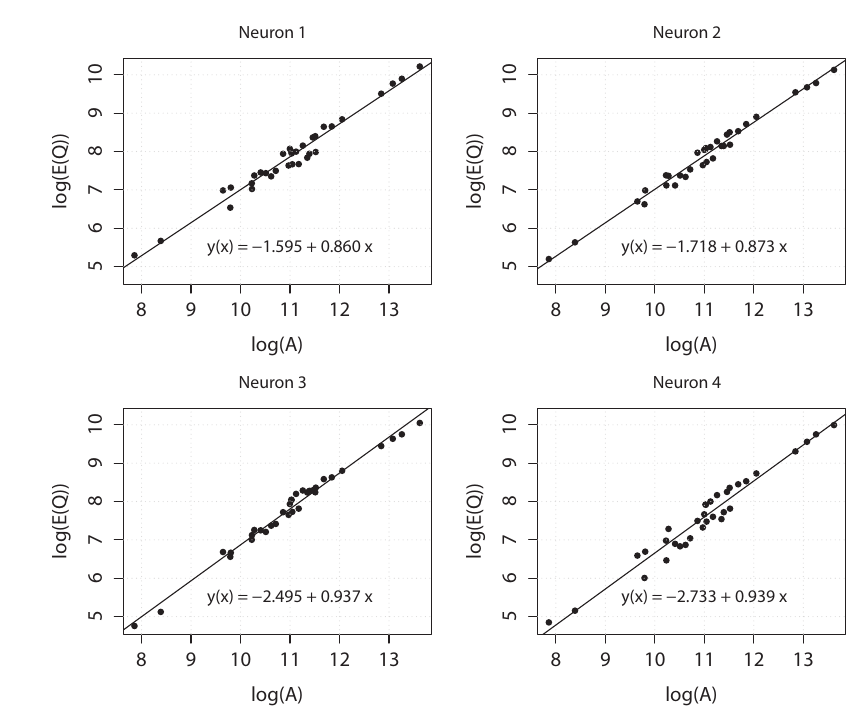
Figure 11. Scaling of average flood flow series in each neuron class. The least-square estimates of intercept and slope are shown in each panel. The black line shows the least-squares regression. Here Q represents the flood series while A represents the drainage area (km 2 ) of the respective